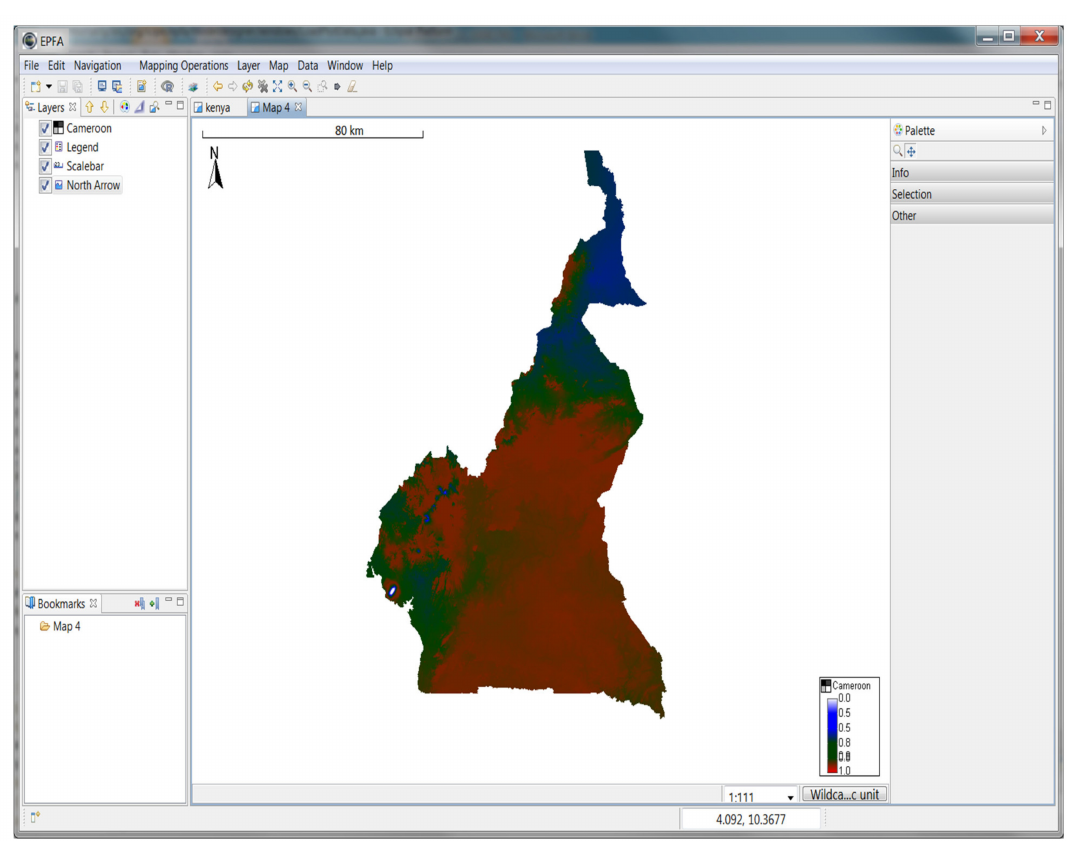
Figure 9. Cameroon map of the potential e ffi cacy of ICIPE 62 isolate when used against mustard aphid, modeled with the software. The level of e ffi cacy varies between 0 and 1. Locations with 0% level of e ffi cacy are displayed in white, values between 0 and 0.5 are displayed in blue, values between 0.5 and 0.75 are displayed in green, and values between 0.75 and 1 are displayed in red. Red indicates the highest e ffi cacy